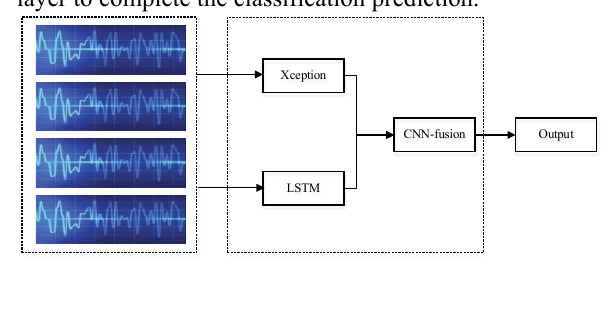
Figure 3. Structure of RCNN